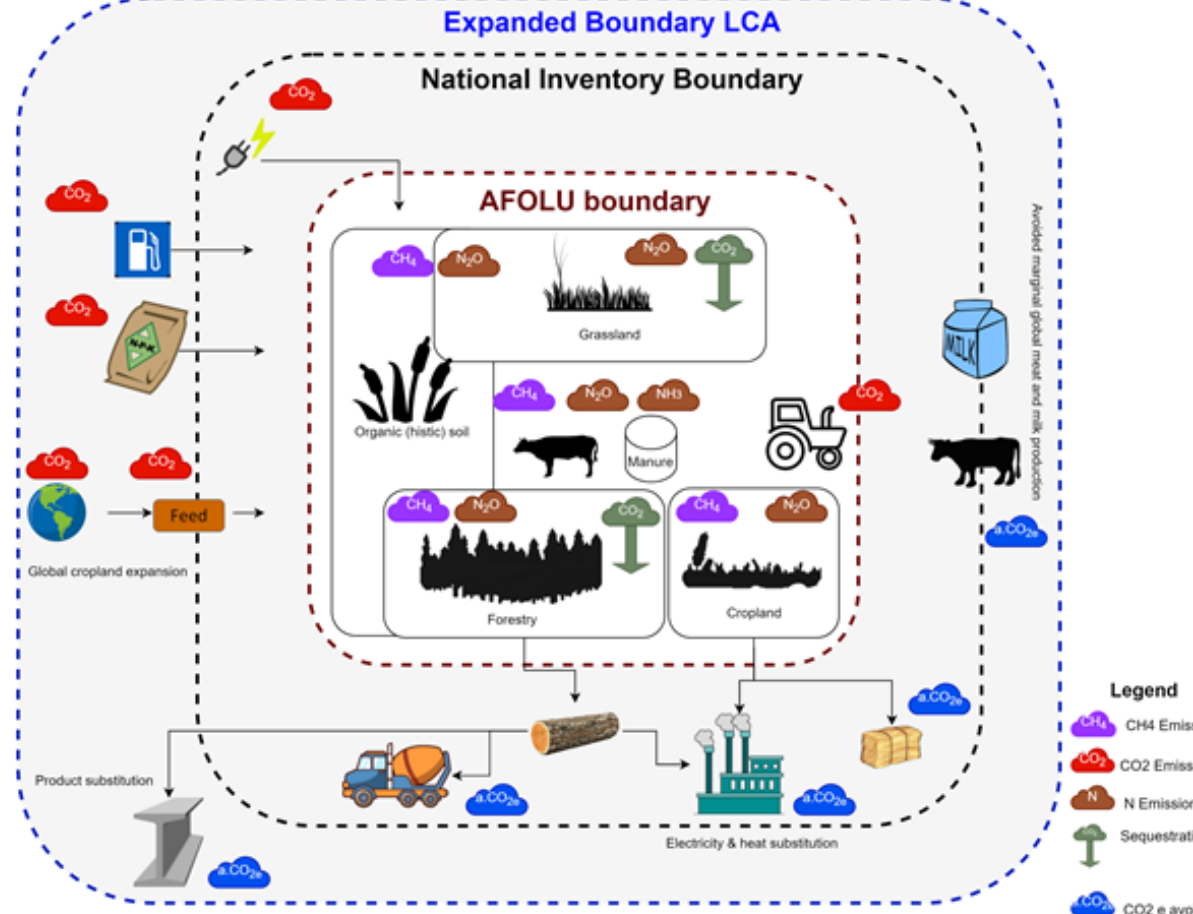
Figure 1. Key emission sources and sinks critical to the determination of “climate neutrality” in Ireland’s AFOLU sector accounted for in GOBLIN (white), alongside linked upstream and downstream sources and sinks to be included in subsequent life cycle assessment (LCA) modelling to determine wider climate mitigation